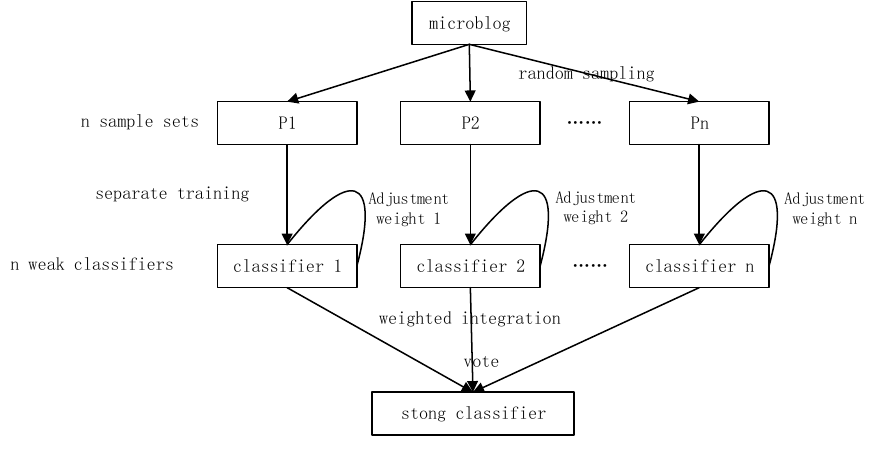
Figure 1. Flow chart of bagging algorithm.